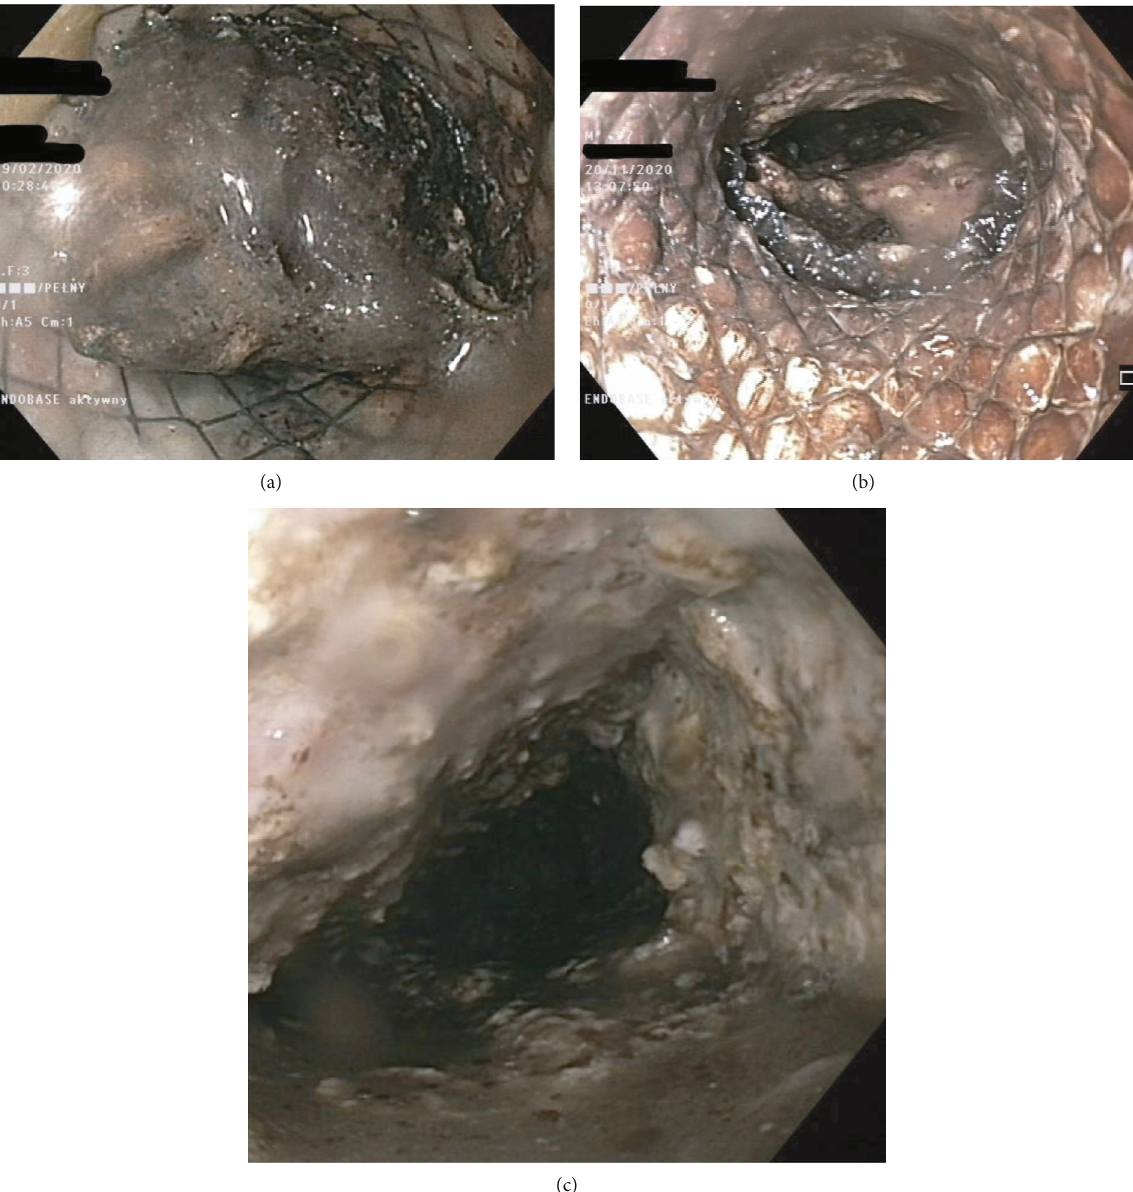
Figure 10: (a – c) DEN of an infected pancreatic necrosis. (a, b) Endoscopic image after insertion of a gastroscope into the lumen of the LAMS. (c) Image from the lumen of the infected WOPN after the gastroscope is delivered through the stent into the fl uid